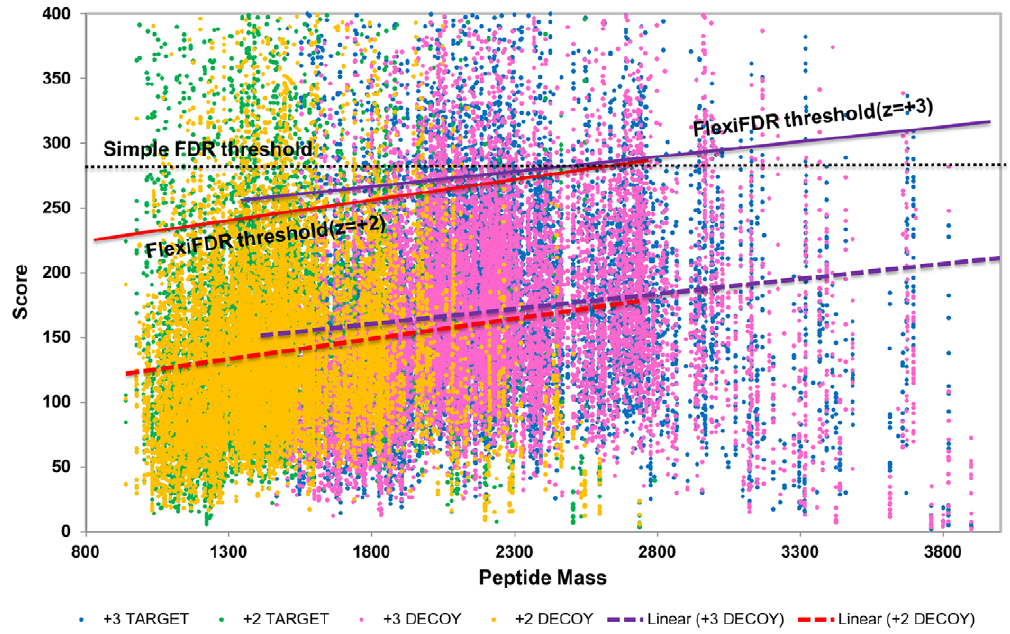
Figure 1. The concept of FlexiFDR method. The linear regression line of decoy hits is represented by the line equation y ~ mx z c to show the effect of increasing mass on decoy hits (PSMs) in QTOF dataset. Two lines are shown for two different charge states ( + 2 and + 3). When a simple FDR is calculated on MassWiz scores (shown by dotted line), many correct hits (green and blue dots) are lost in lower mass regions with high density. The FlexiFDR method uses a line y 0 ~ mx z c 0 for every charge state (colored solid lines), parallel to the decoy line of that charge, as a dynamic threshold based on decoy results to estimate FDR. The scores are transformed using this equation of line. This method helps in enhancing the true hits and decreasing the false hits at , 1%FDR and reduces the time spent for manual validation.